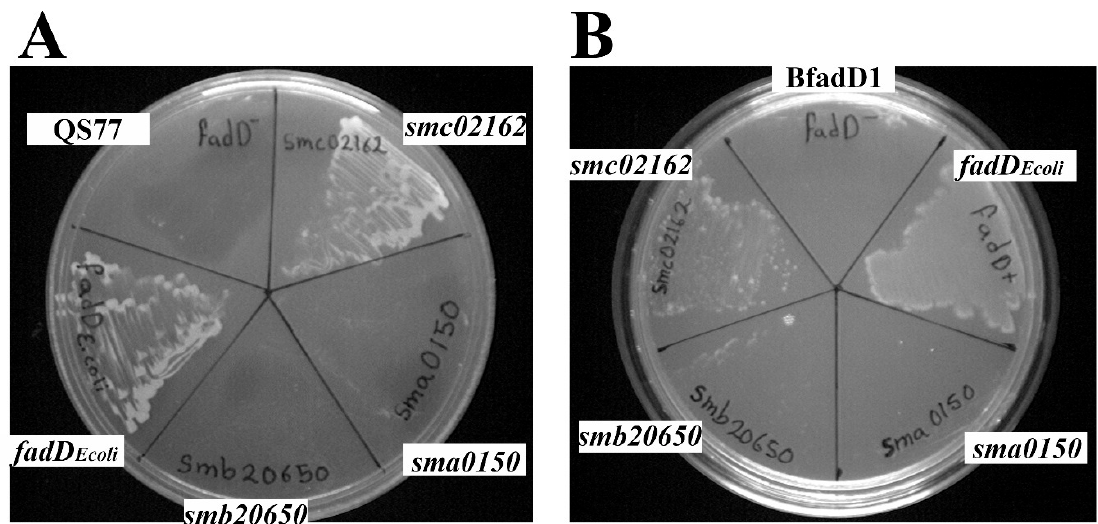
Figure 1. Expression of smb20650 or sma0150 in S. meliloti or E. coli fadD mutants does not restore growth on oleate. ( A ) The growth of S. meliloti fadD mutant QS77 carrying the empty vector pNG28 (QS77), pRCanul2 ( smc02162 ), pRCanul1 ( sma0150 ), pRCanul3 ( smb20650 ), or pRCanul4 ( fadD Ecoli ) on Robertsen minimal medium (MM) with 5 mM oleate as a sole carbon source and 5 mg / mL Brij 58. ( B ) The growth of E. coli fadD mutant BfadD1 pLysS carrying pET17b (BfadD1), pECH8 ( fadD Ecoli ), pECH1 ( sma0150 ), pECH7 ( smb20650 ), or pECH6 ( smc02162 ) on M9 MM containing 5 mM oleate as a sole carbon source, 5 mg / mL Brij 58, and 0.1 mM isopropyl- β -D-thiogalactopyranoside (IPTG). S. meliloti QS77 pNG28 and E. coli BfadD1 pLysS pET17b were used as